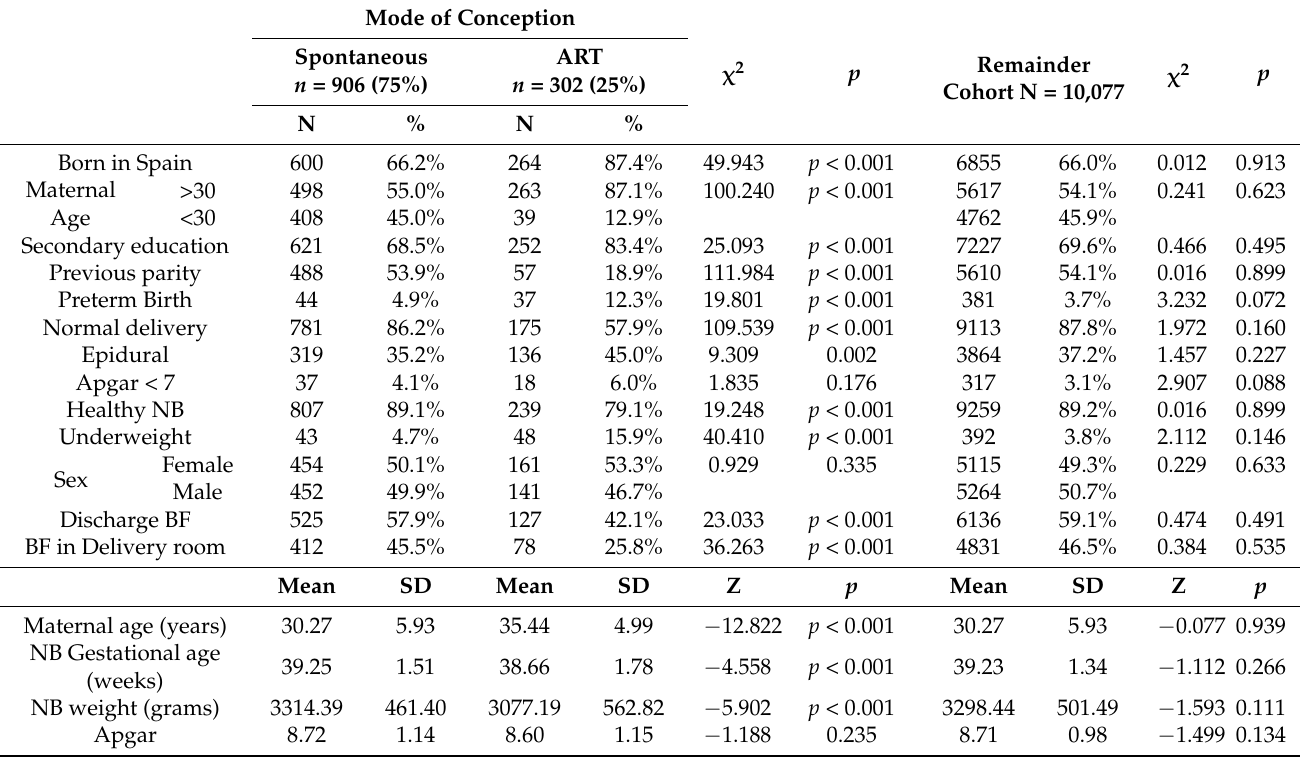
Table 1. Sociodemographic data of the sample (n =